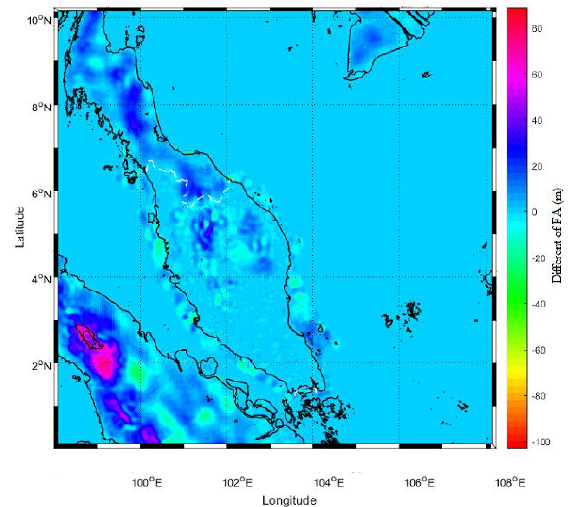
Figure 5 Two strategies for gridding of the free air anomaly Figure 6 shows the difference between 1′x1′grid of surface free air gravity anomalies computed via first strategy and second strategy, respectively. Meanwhile, the statistical analysis of the both gridded surface anomalies is reported in Table 2. As shown in Table 2, the mean and standard deviation of the gridded surface gravity anomaly from the Strategy 2 give lower value than Strategy 1.